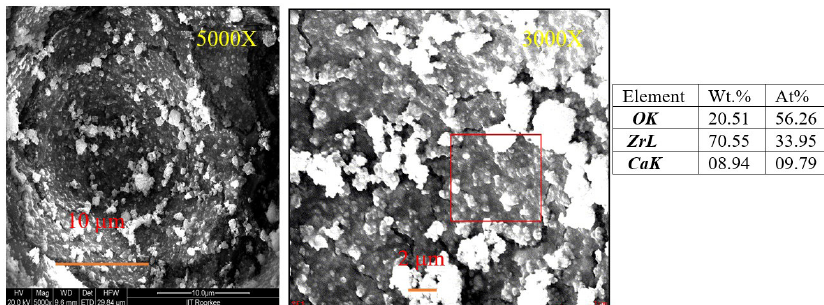
Figure 3. SEM and EDS analysis for 15 mol % CaO powder sample.